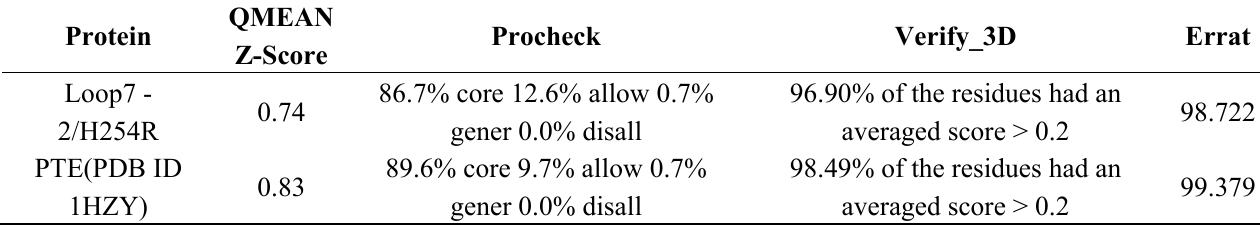
Table 1. Homology model validation with QMEAN, Procheck, Verify_3D and Errat.